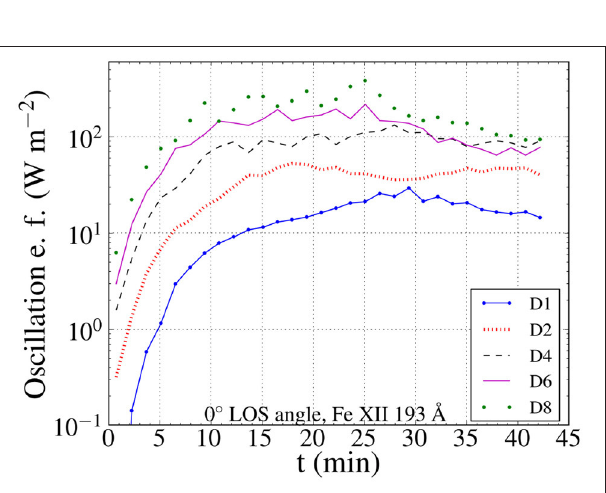
FIGURE 9 | Average values of the total observed (Doppler and non-thermal) energy fluxes with the additional term by tracking the oscillation on the POS. The values are based on the synthetic images for the Fe XII 193 Å line and the 193 AIA